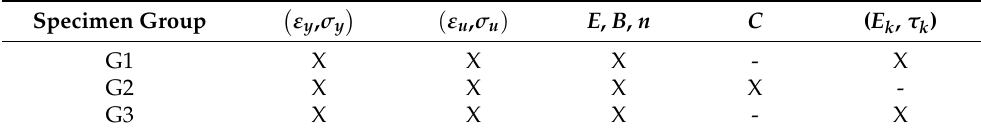
Table 2. Computed parameters for each specimen